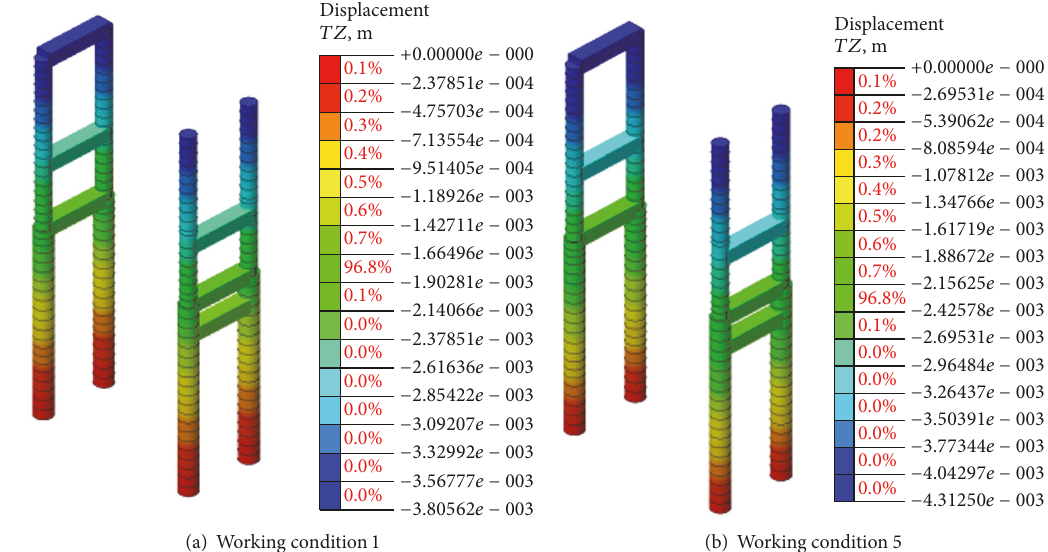
Figure 23: Vertical displacement of bridge piles and columns.